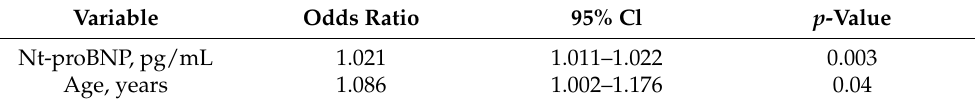
Table 3. Univariate analysis of predictive factors for the occurrence of death in patients with